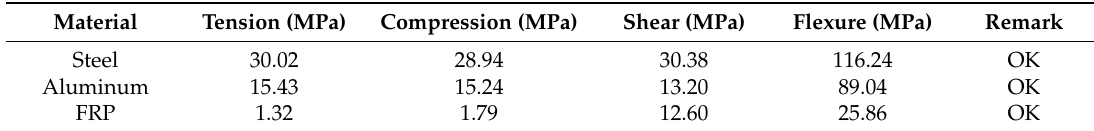
Table 10. FE analysis results of steel, aluminum, and FRP.